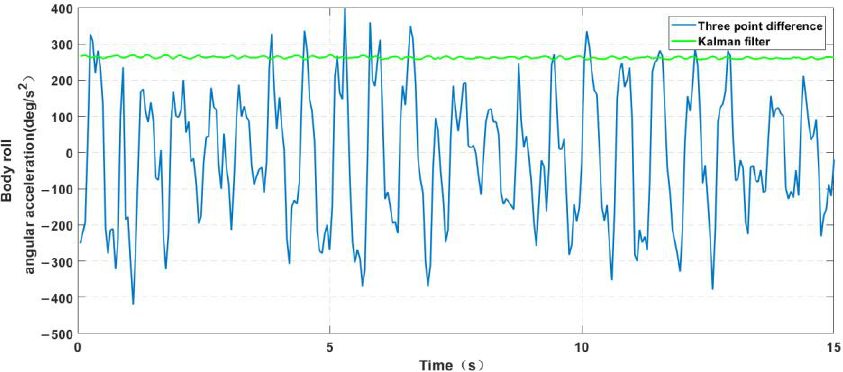
Figure 22. Experimental results: θ ̈ diff and θ ̈ KF when running SGCMG with the car at rest. As can be seen from the above figure, the quality of the θ ̈ KF signal after Kalman filtering is greatly optimized compared to θ ̈ , but there is a static difference in θ ̈ KF , which is caused by the angular error in the Gravity moment part of the a priori estimate in Kalman filtering, which is determined by the current roll angle of the vehicle and the balance angle of the vehicle itself. In the practical application of the controller, this static difference is offset by the frame angle.